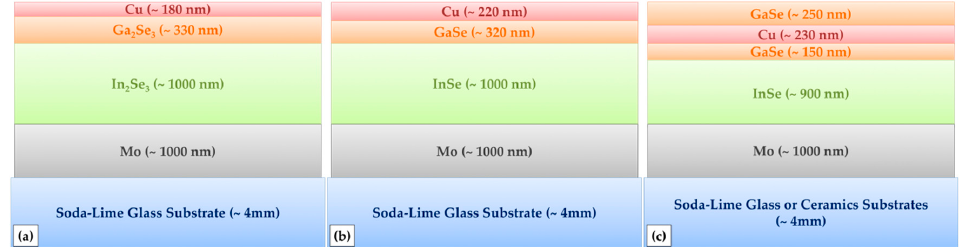
Figure 1. The different precursor layers and sequences used to obtain the absorber material reviewed